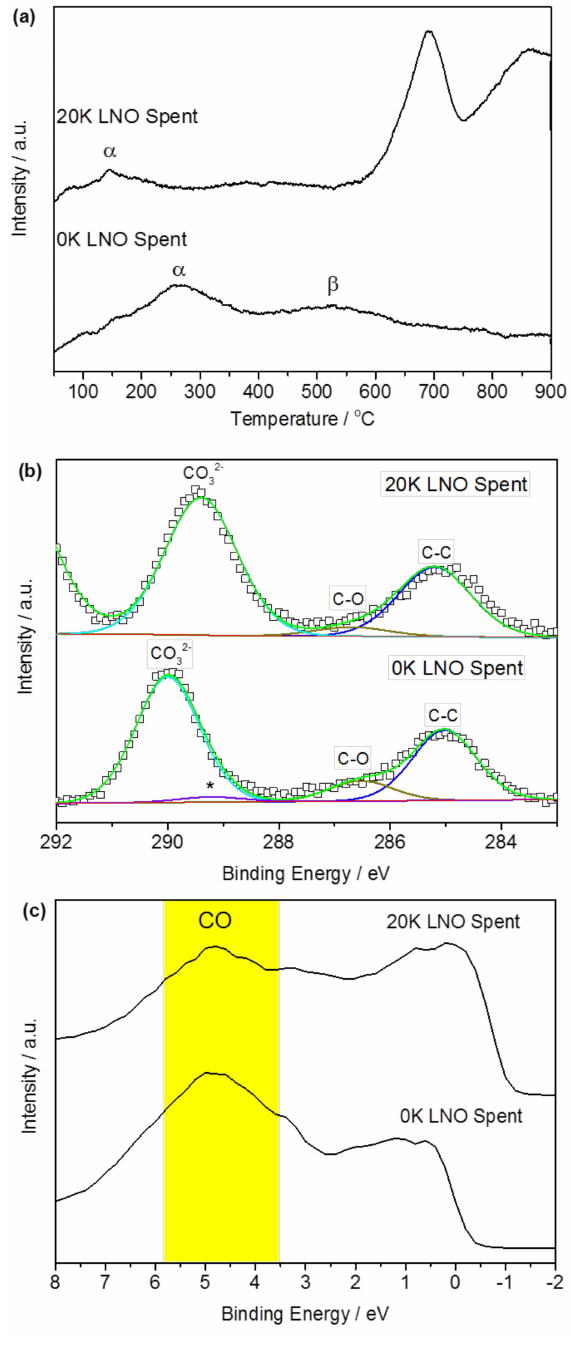
Figure 8. ( a ) CO-TPD profiles of the 0K and 20K LNO samples. ( b ) C1s spectra of the spent 0K and 20K LNO samples after a 2-h reduction step and 5-h reaction period at 300 ◦ C. ( c ) XPS valence band spectra of the same spent